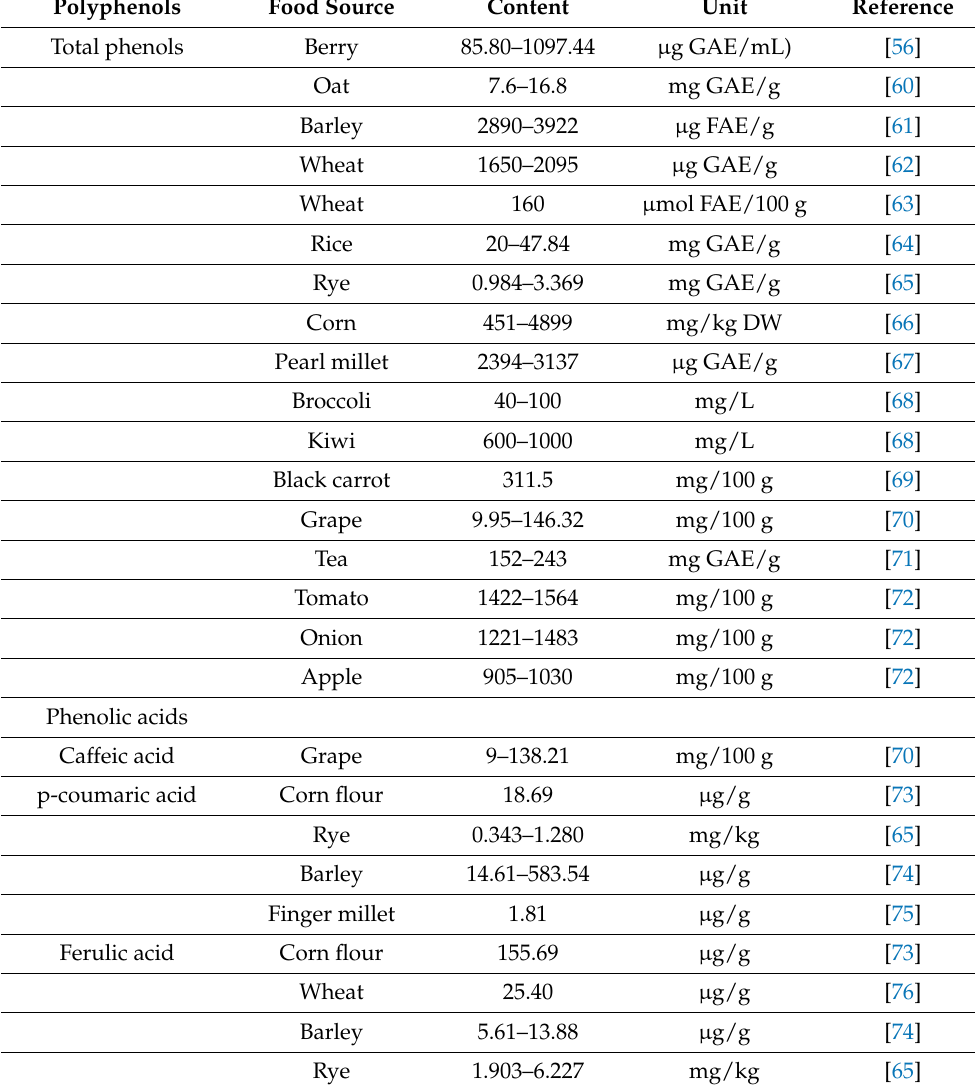
Table 1. Sources of